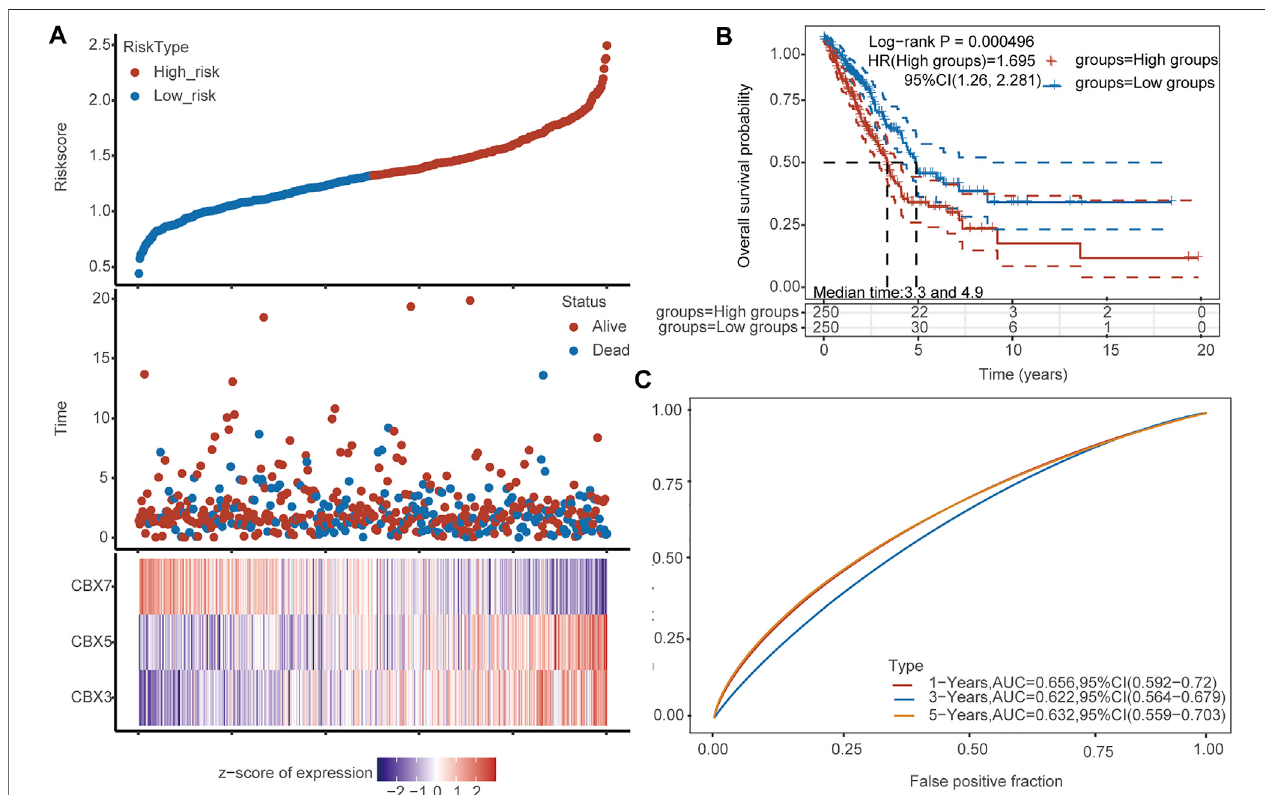
FIGURE 6 | Analysis of the diagnostic value of CBX3/5/7. (A) Patients were divided into low- and high-risk groups according to the median risk score. Heatmap of the expression pro fi les of the prognostic genes in the low- and high-risk groups. (B) Both groups of LUAD patients have signi fi cant prognostic differences. (C) Time- dependent ROC analysis based on the CBX